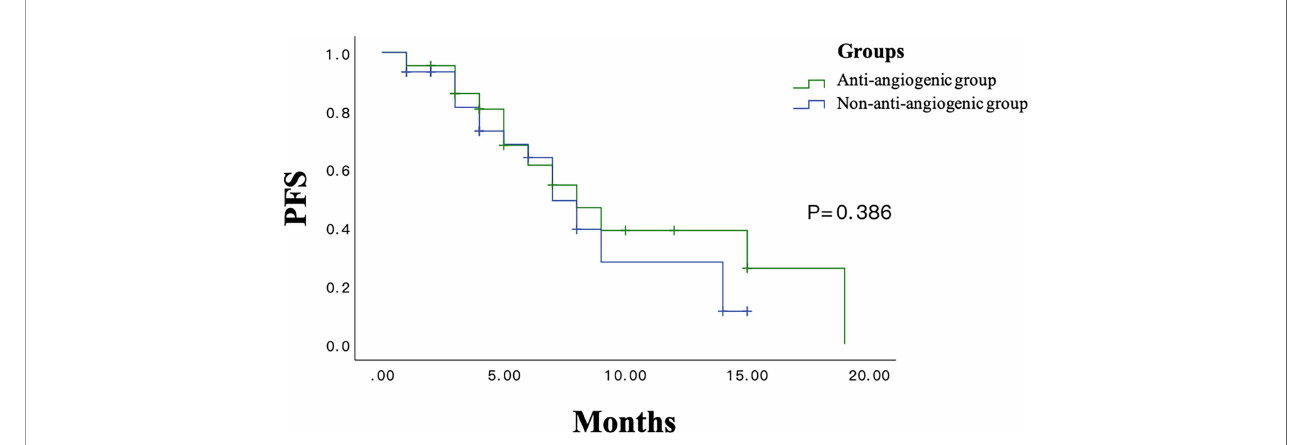
FIGURE 2 | The PFS Survival Curve in Anti-angiogenic Groups and Non-anti-angiogenic Groups.